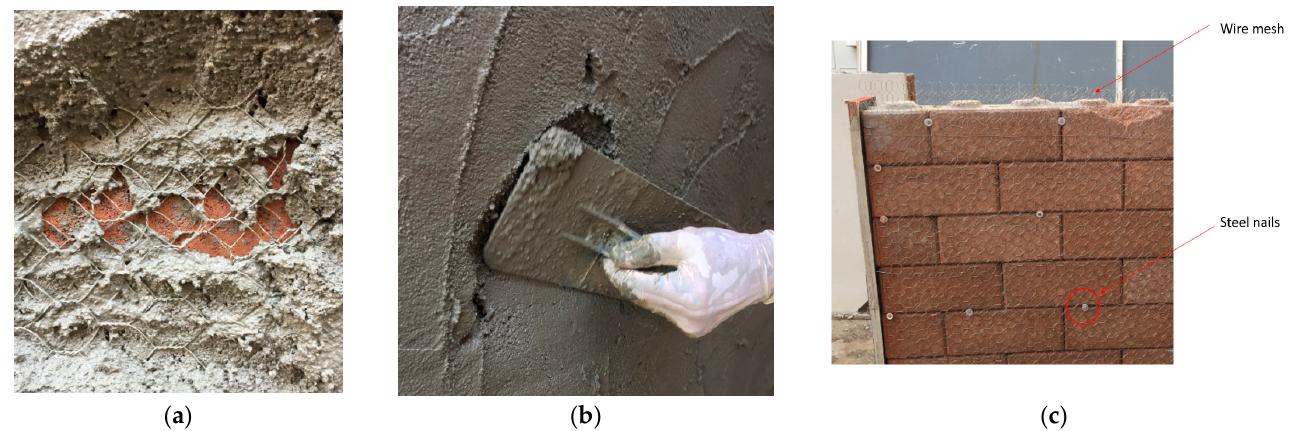
Figure 3. Application of wire mesh and CS mortar: ( a ) Wire mesh and cement mortar; ( b ) cement mortar; ( c ) attachment of wire mesh.